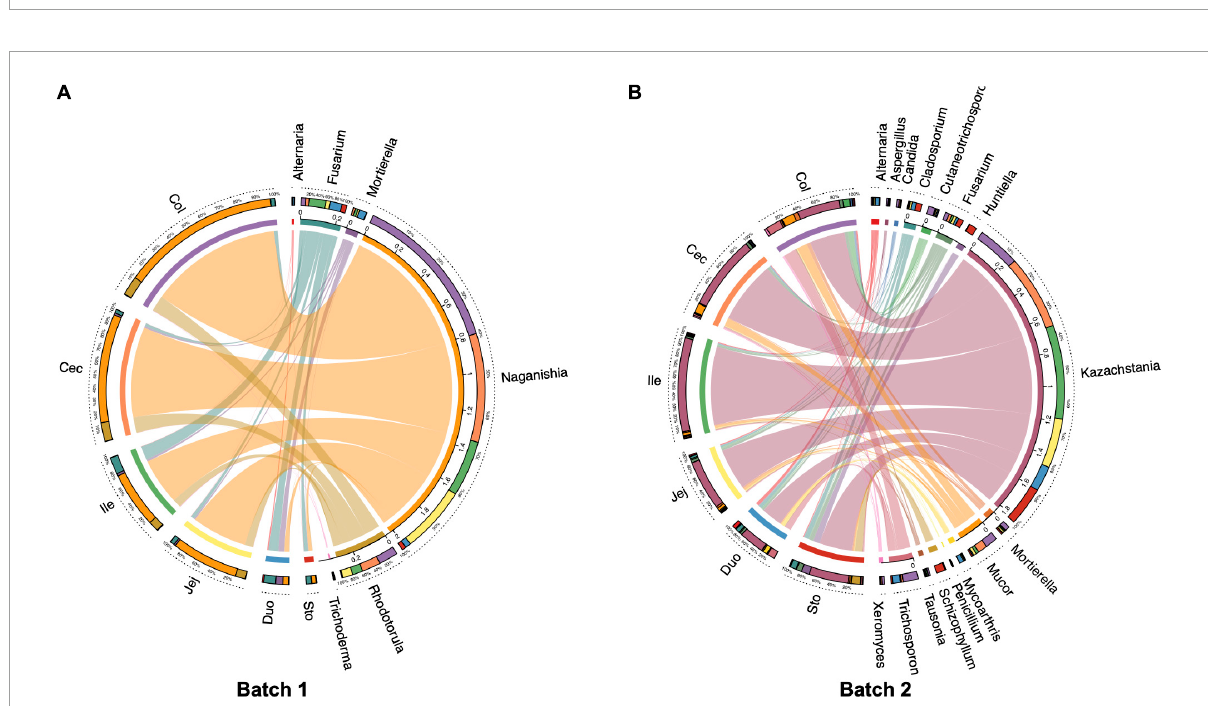
FIGURE5 Circos plot showing the distributions of core fungal genera in different regions of the gastrointestinal tract in the pigs (present in more than 80% of all digesta samples). (A) Batch 1, (B) Batch